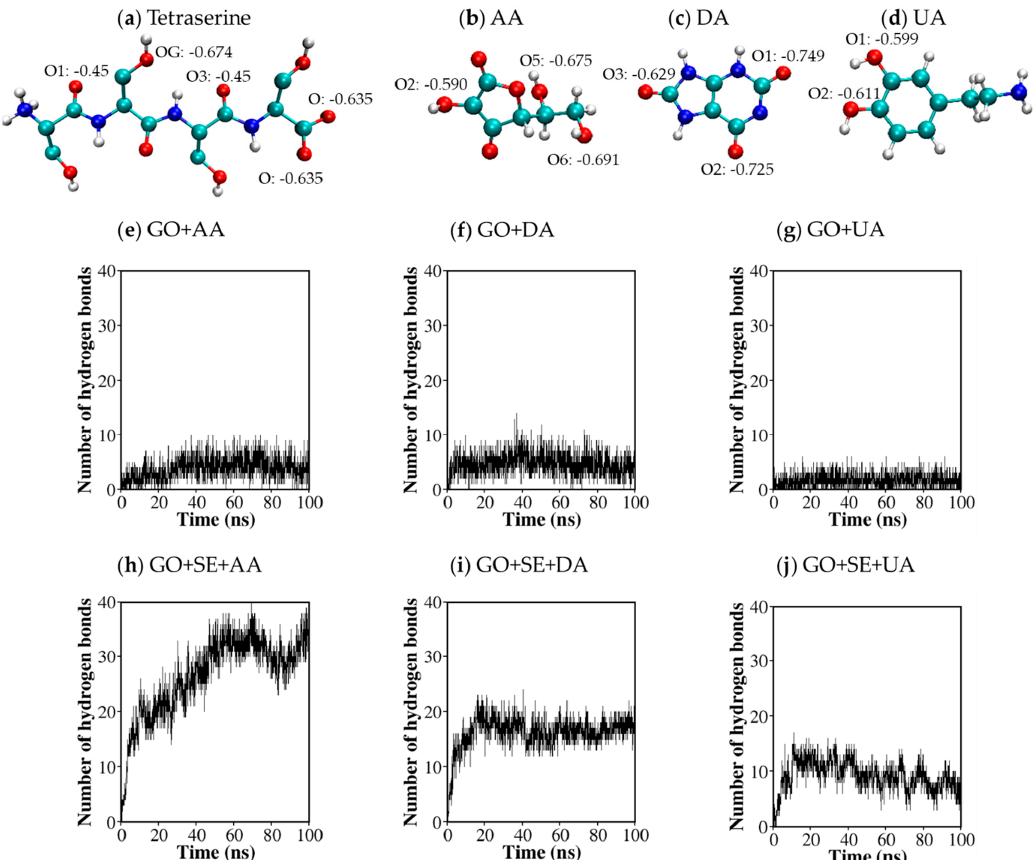
Figure 5. ( a ) Atomistic structures and partial charges within a tetraserine molecules in accordance with the GROMOS54a7 forcefield; ( b – d ) atomistic structures and partial charges of ( b ) AA; ( c ) DA; and ( d ) UA molecules in accordance with the GROMOS54a7 forcefield and 631G* DFT calculations; ( e – g ) number of hydrogen bonds between the ( e ) AA; ( f ) DA; and ( g ) UA analytes and GO; ( h , i ) number of hydrogen bonds between the ( h ) AA; ( i ) DA; and ( j ) UA analytes and tetraserines.